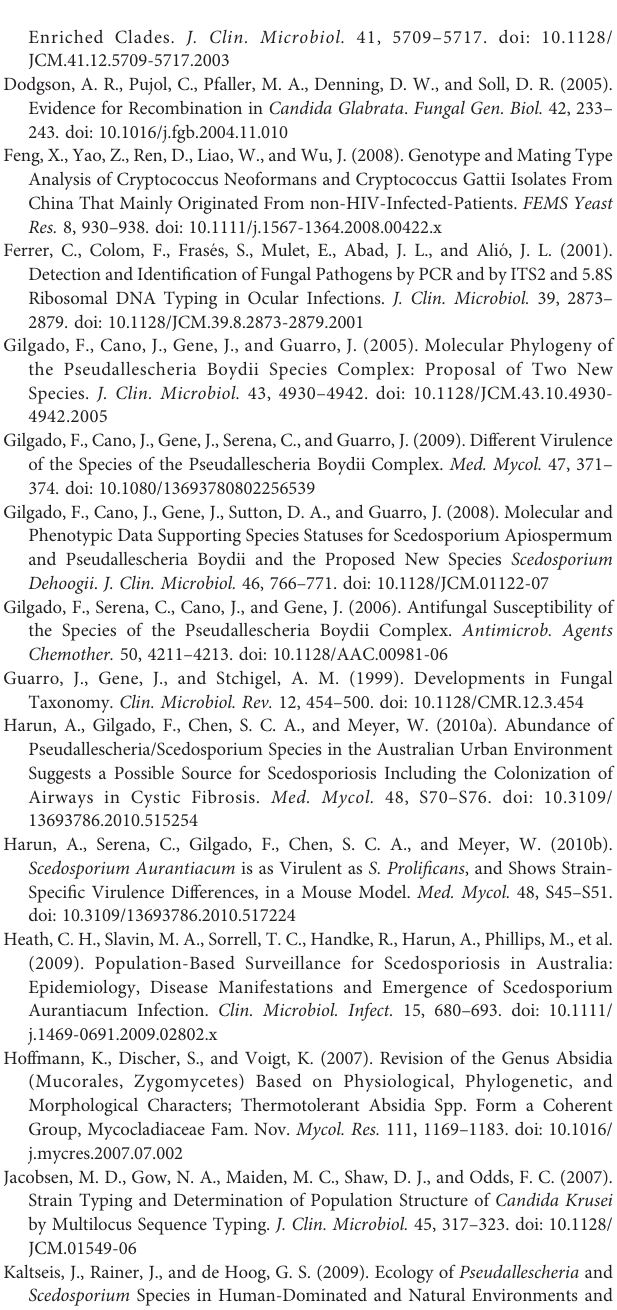
the program MEGA version 11 (numbers on the branches indicate bootstraps values above 50). Supplementary Table 1 | List of primers used in the MLST scheme